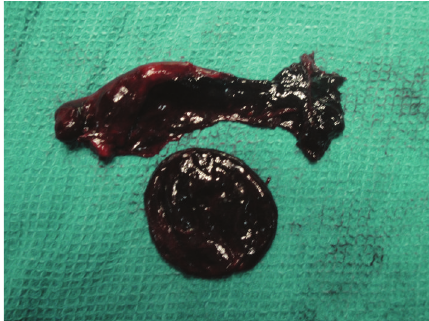
Figure 2: Left fallopian tube with paratubal